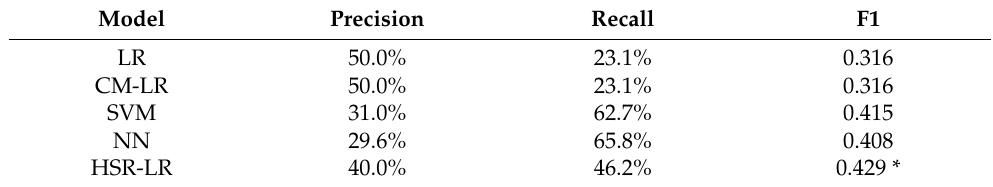
Table 5. Results on